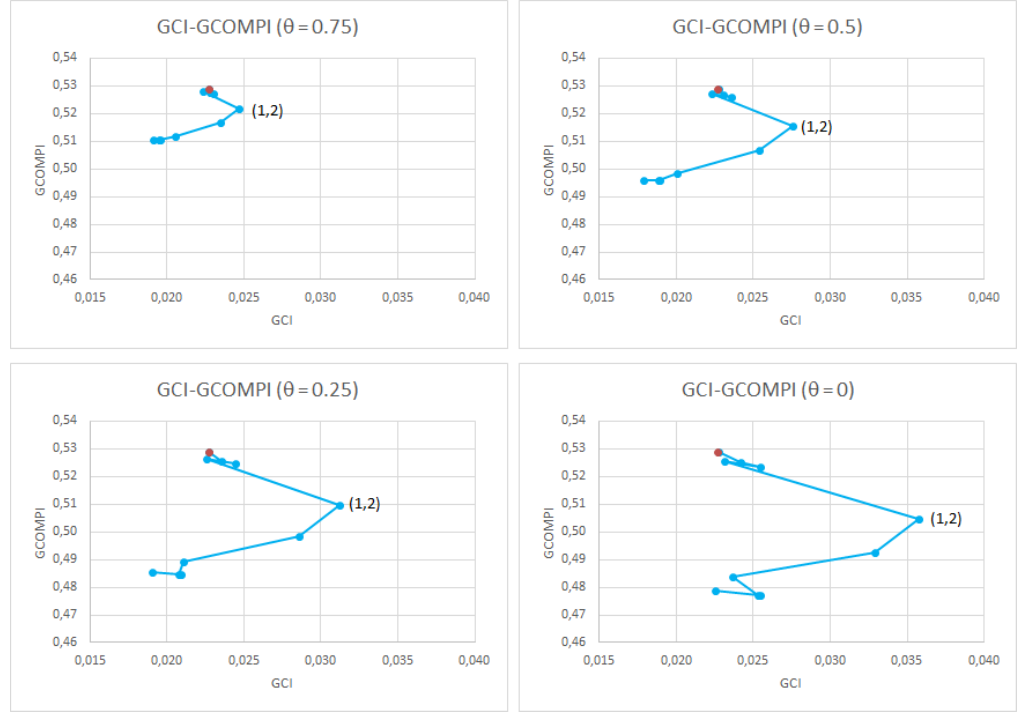
Figure 1. GCI and GCOMPI values for the iterative procedure for different values of θ . Red points correspond to the initial values of the iterative process.